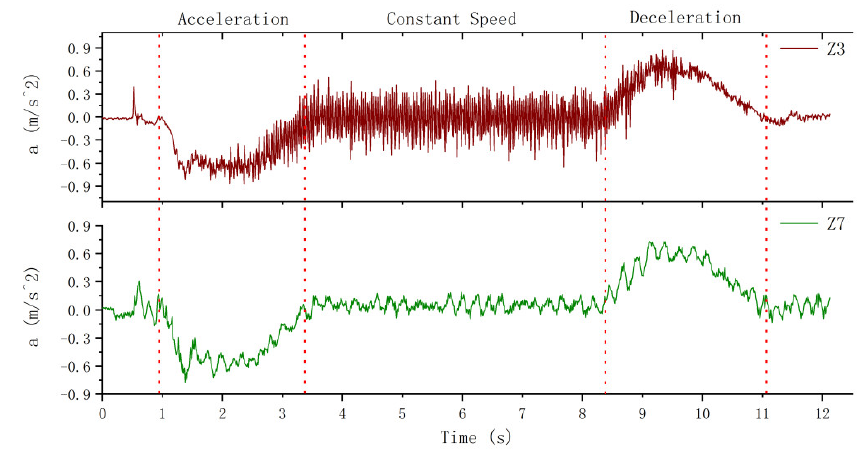
Figure 13. Comparison of longitudinal vibration between the hoist rope and car frame.